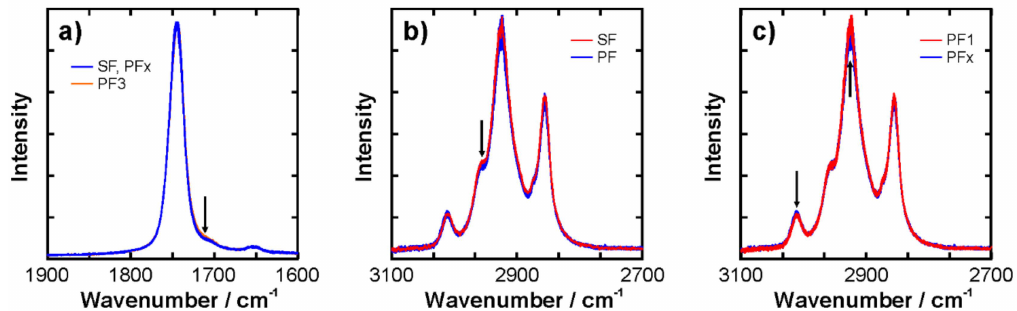
Figure 3. Color-coded raw spectra in selected spectral ranges: ( a ) C = O stretching region and ( b , c ) CH stretching